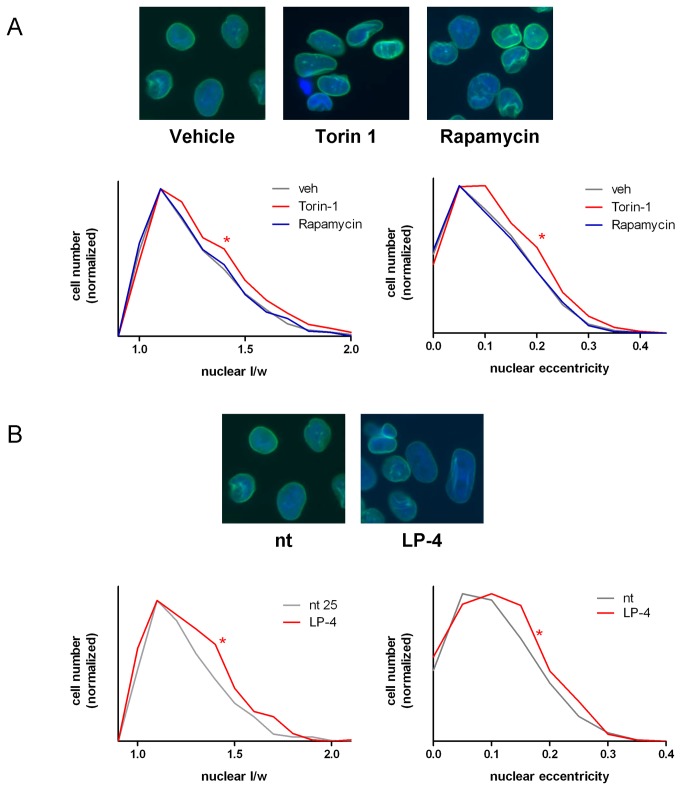
LPAAT-β siRNA treatment results in increased nuclear eccentricity.MiaPaCa2 cells were treated (A) for 24 hr with 500 nM Torin-1 (* p < 0.0001), 10 nM rapamycin, or DMSO vehicle and (B) for 72 hr with 25 nM LP-4 (* p = 0.05) or non-targeting (nt) siRNA. Nuclei were stained with antibody to Lamin A to highlight the nuclear membrane as well as counterstained with DAPI. Analysis of the images using Definiens Tissue Studio software generated the length and width of individual nuclei, which were then analyzed for enhanced nuclear eccentricity as described in Materials and Methods. Graphs show the frequency distribution of nuclear eccentricity and nuclear l/w normalized to cell number. Statistical significance was determined using Student’s t-test. Results are representative of four independent experiments.